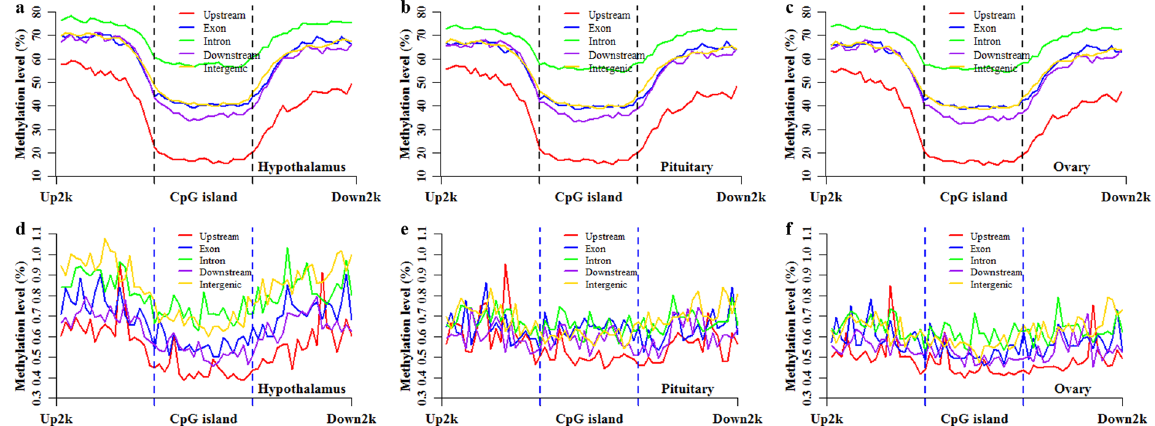
Figure 4. Methylation patterns of CGIs located in different genic features. The CpG methylation patterns of CGI locations in the hypothalamus ( a ), pituitary ( b ) and ovary ( c ). The CpH methylation patterns of CGI locations in the hypothalamus ( d ), pituitary ( e ) and ovary ( f ).